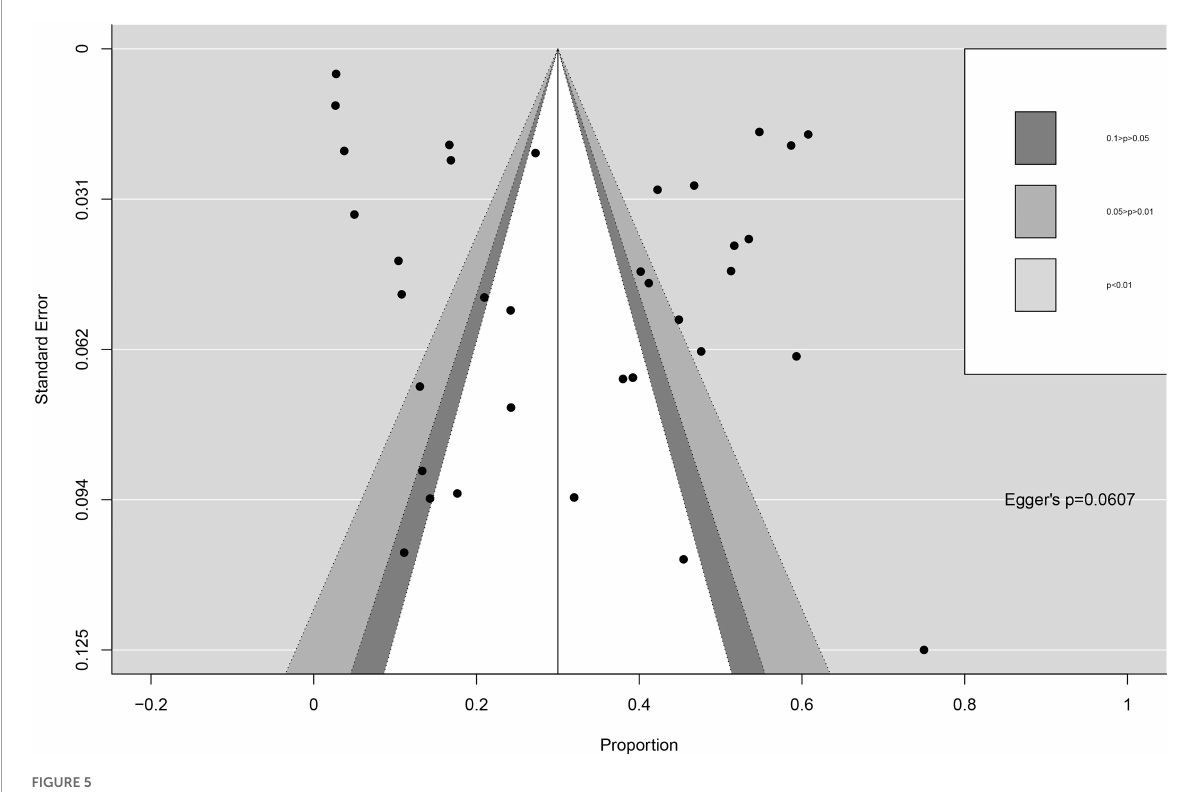
FIGURE5 Funnel plots and Egger’s regression